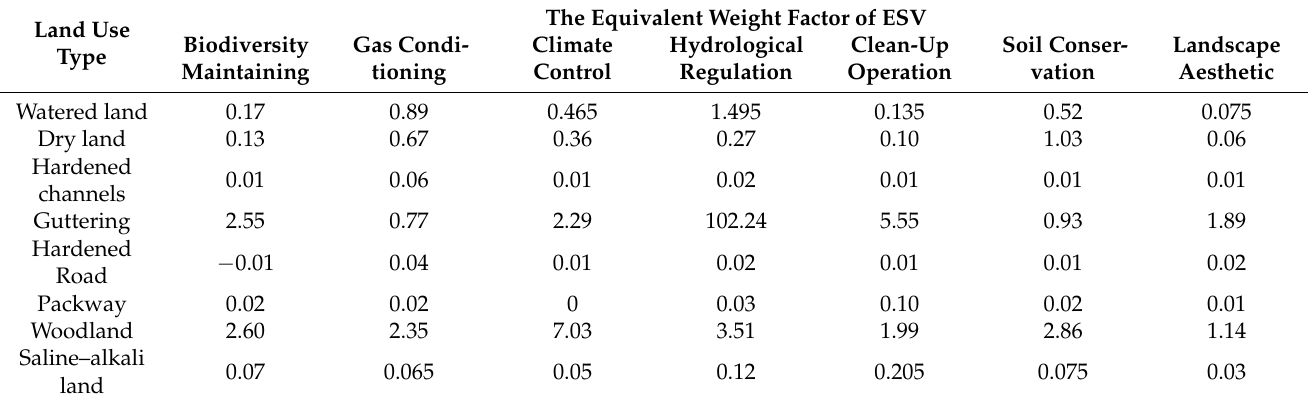
Table 4. Equivalent factor of ecosystem service value per unit